Question: State the chart type depicted above.
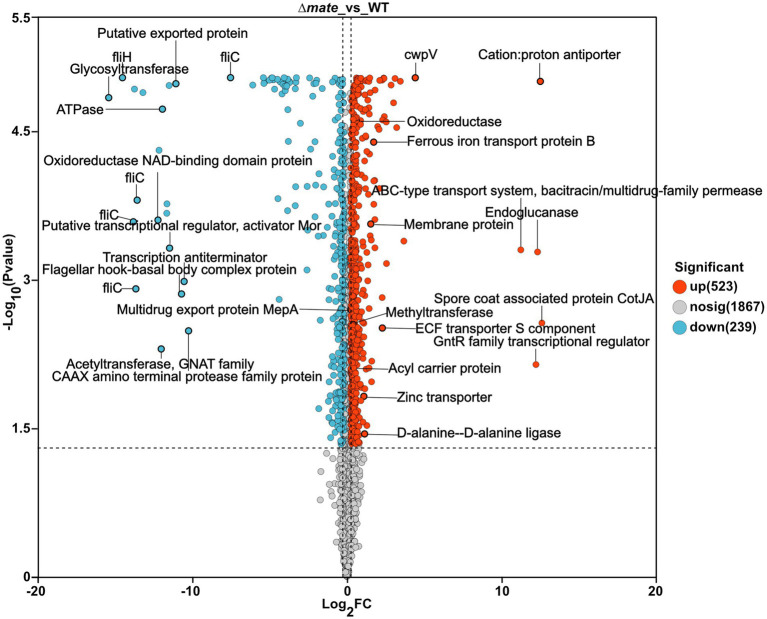
Answer: scatter